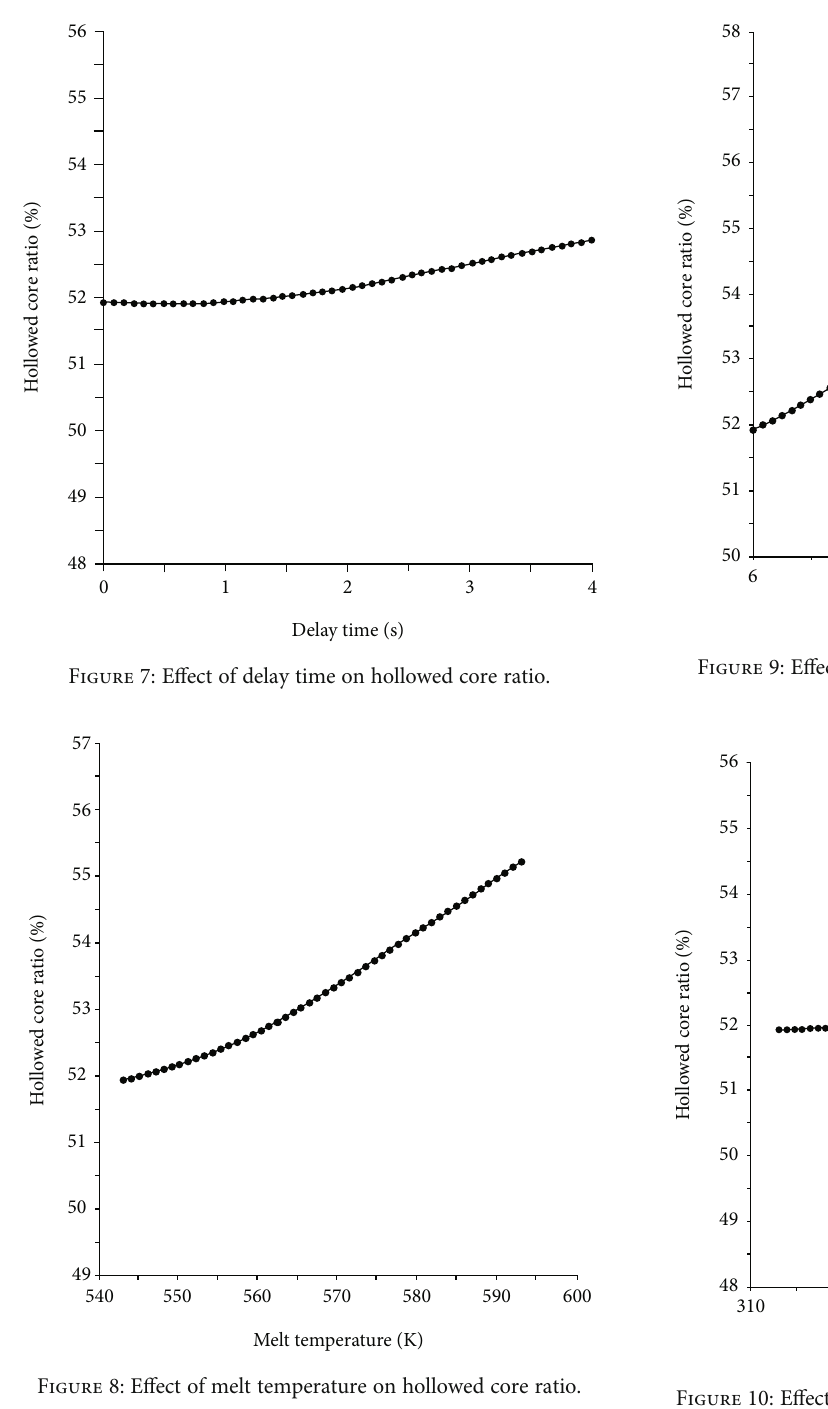
Figure 10: E ff ect of mold temperature on hollowed core